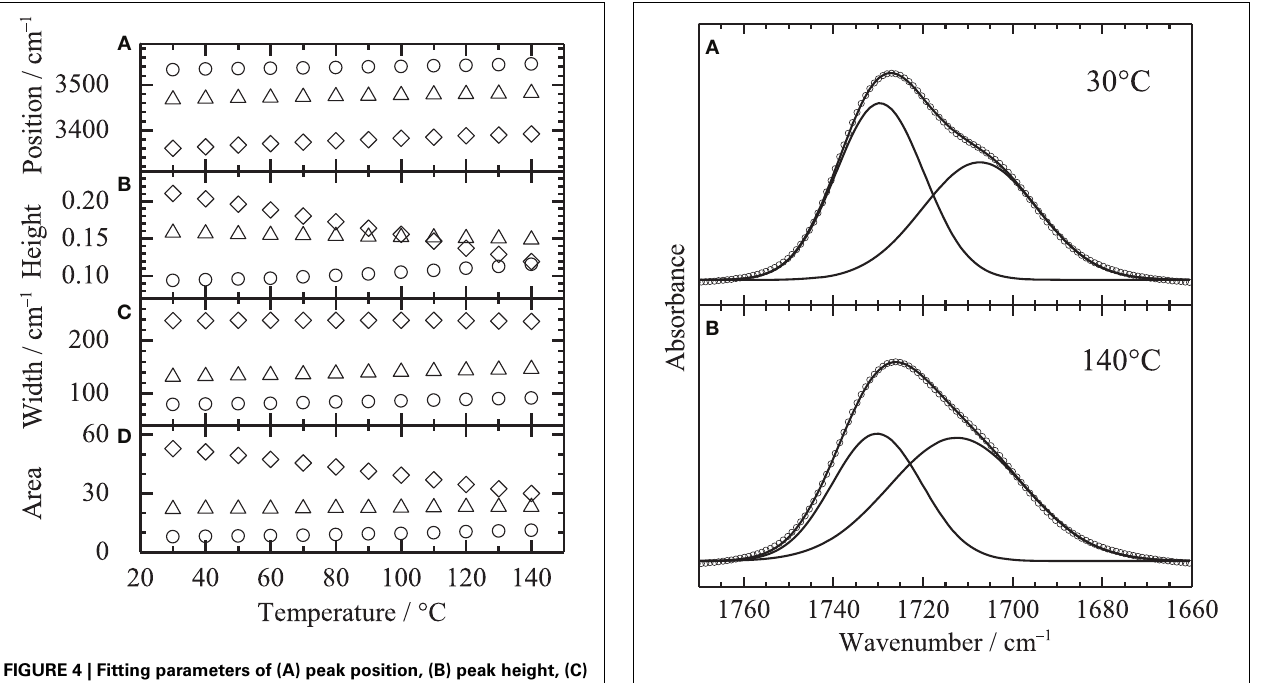
FIGURE 6 | Typical results of the curve fitting in the C = O stretching region assuming two Gaussian components at (A) 30 ◦ C and (B) 140 ◦ C. Circles and lines in the figure correspond to observed data and fitted lies with the two